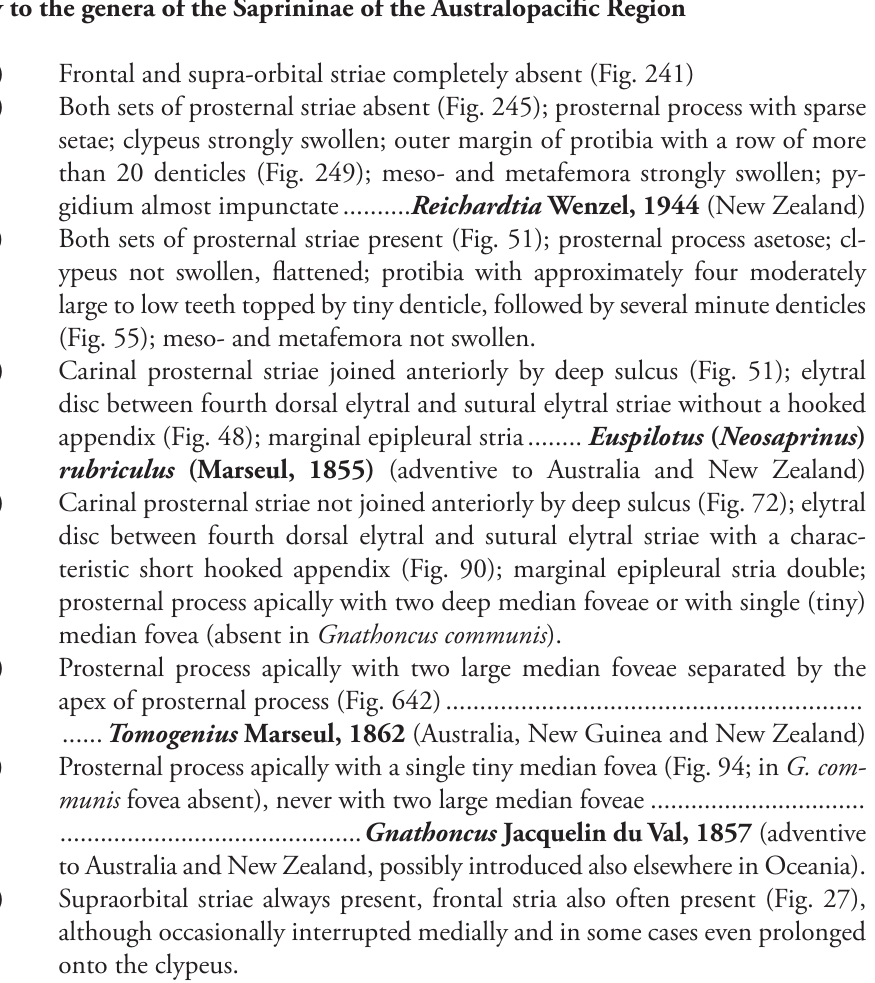
Abbreviations. Abbreviations of morphological measurements follow